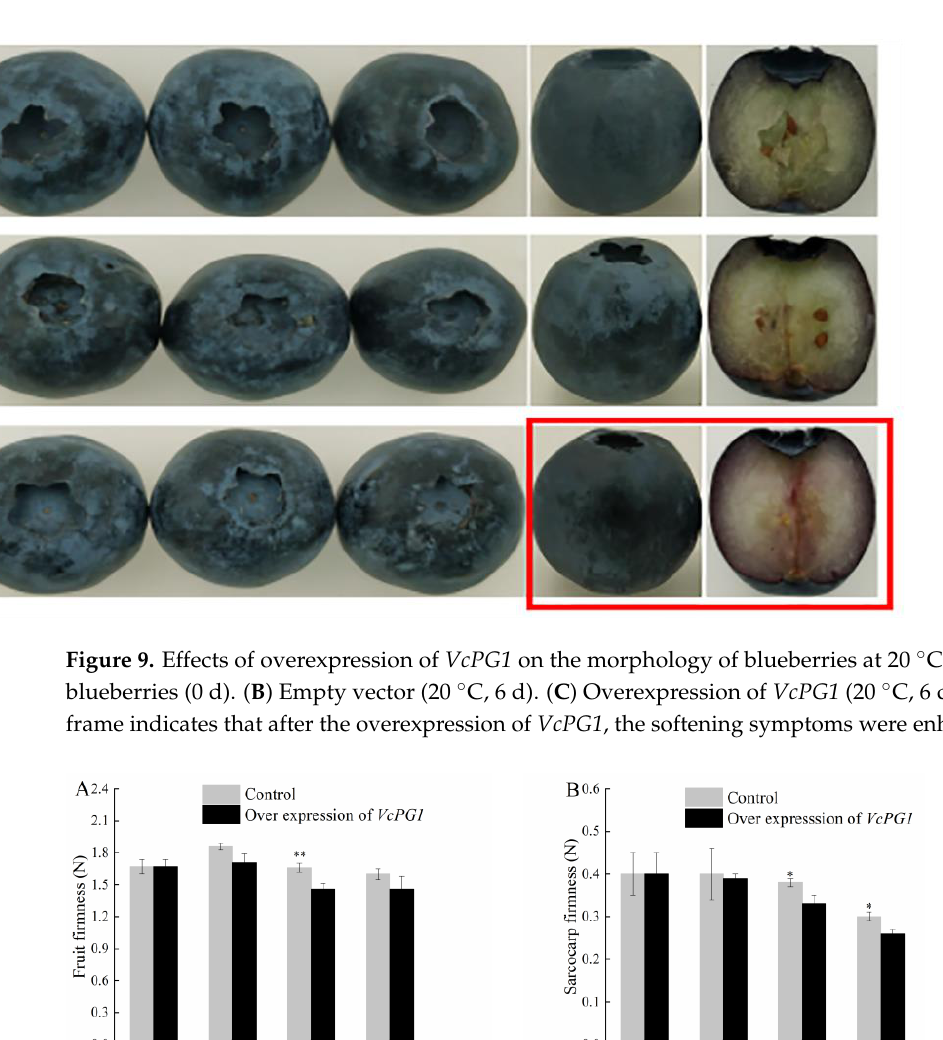
Figure 8. Changes in VcPG1 expression in VcPG1 − OE blueberries. The control fruit was injected with empty vector Agrobacterium tumefaciens. Asterisks indicate significant differences between control and overexpressing VcPG1 treatment fruit (* p < 0.05).